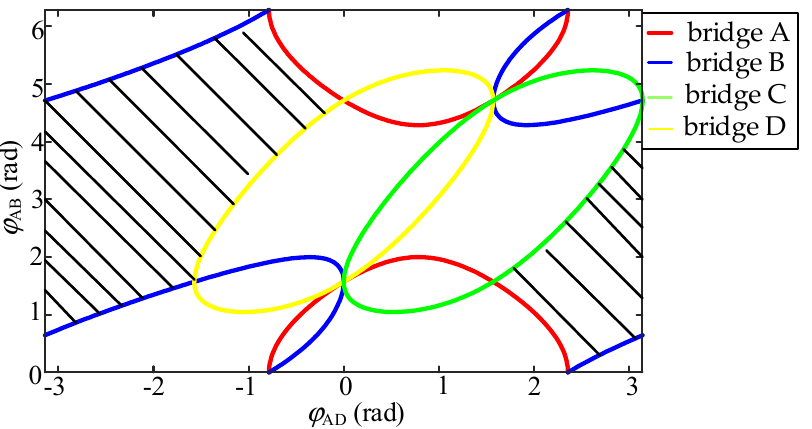
Since TPS contains three control quantities, in order to display the soft-switching area in the two-dimensional coordinate system, it is taken here that ϕ DC = 90 ◦ for simulation. The ZVS area of the full-bridge arm drawn by Matlab is shown in Figure 8.